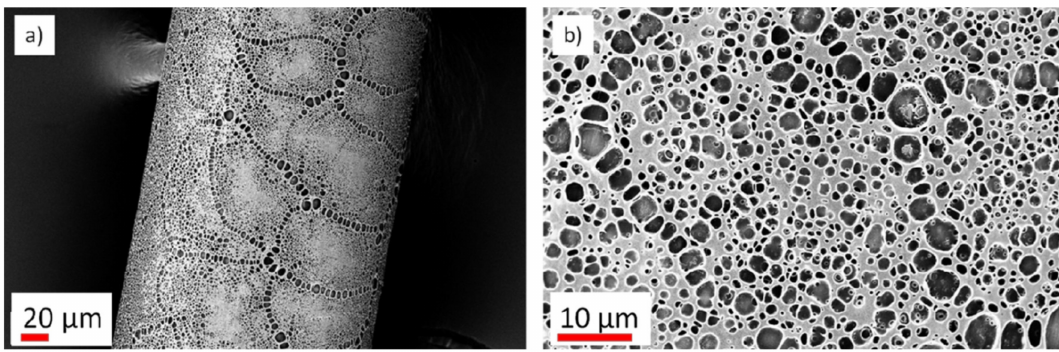
Figure 9. SEM images of PCL coated melt-spun AN / VIM fiber loaded with NO: ( a ) at low magnification, ( b ) at higher magnification showing the pores in the PCL surface layer. Reprinted with permission from [89]. Copyright © 2012 American Chemical Society.